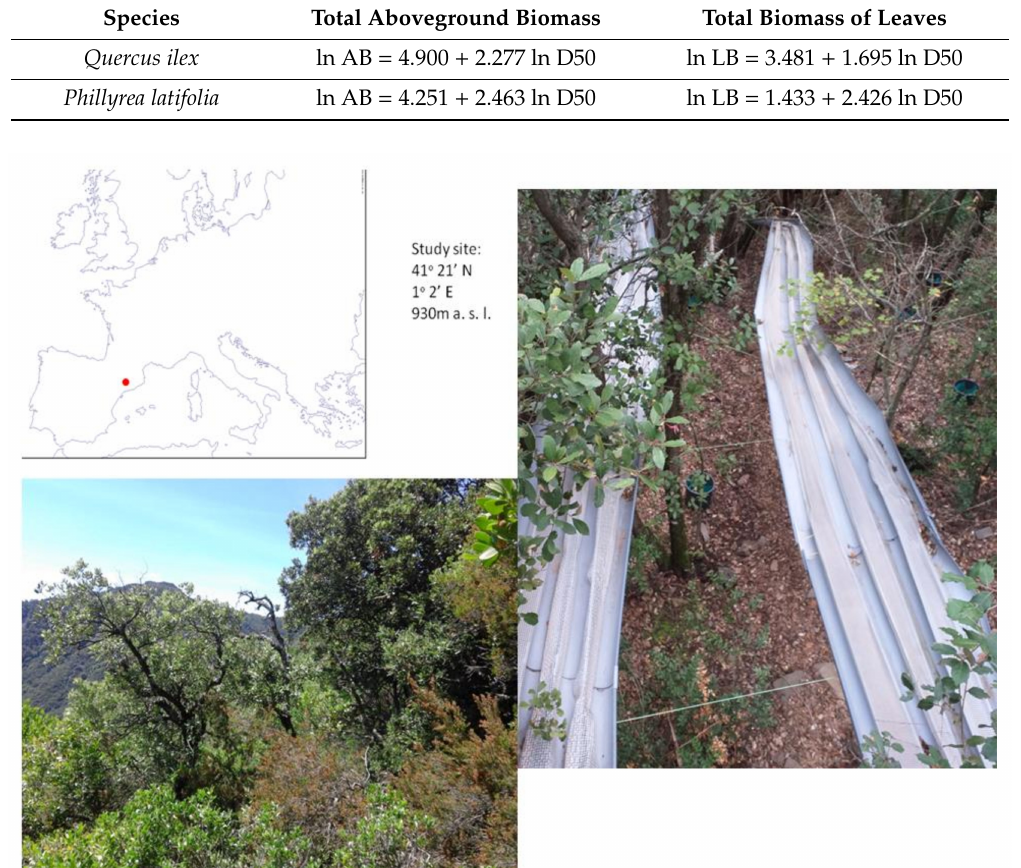
Table A1. Allometric relationships between total aboveground biomass (AB) and total biomass of leaves (LB) from stem diameter at 50 cm height (D50), in Q. ilex and P. latifolia .